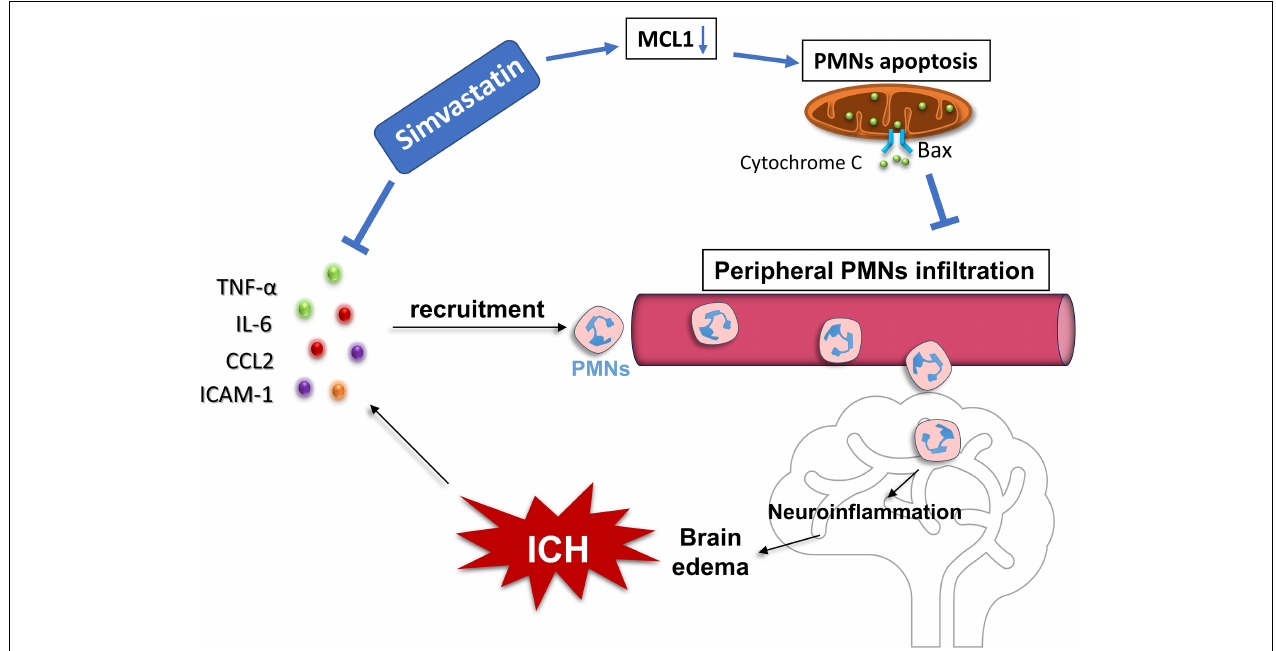
FIGURE 7 | Proposed mechanism underlying simvastatin-mediated against PMNs brain-invading after ICH. It mainly depends on two approaches. On the one hand, simvastatin significantly inhibited the transcription of chemokines and vascular cell adhesion molecule, such as TNF- α , IL-6, CCL2, and ICAM-1, which subsequently reduced the chemotaxis and recruitment of peripheral neutrophil into brain after ICH. On the other hand, through down-regulated the expression of antiapoptotic protein-Mcl-1 while increased the level of proapoptotic protein-Bax expression in PMNs, resulting in more cytochrome C releasing out from mitochondria and caspase 3 activating, which then promoted the apoptosis of PMNs and cut down the number of circulating PMNs.